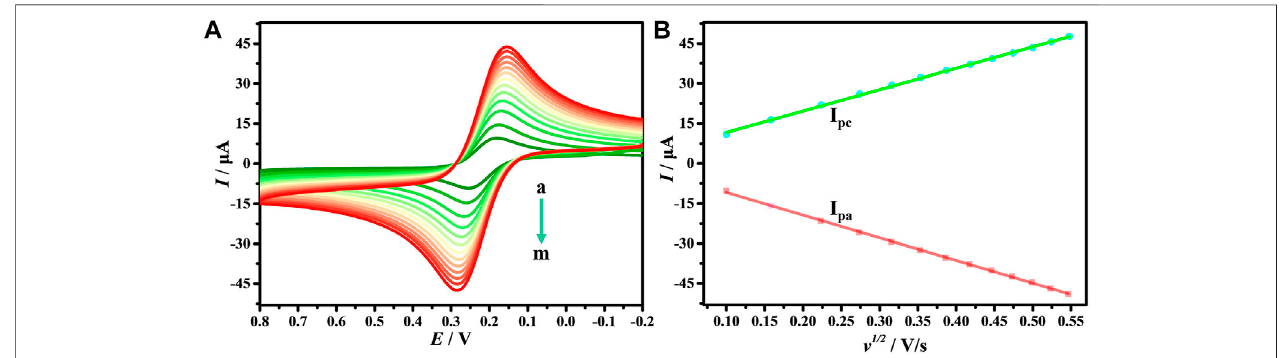
Frontiers in Chemistry |